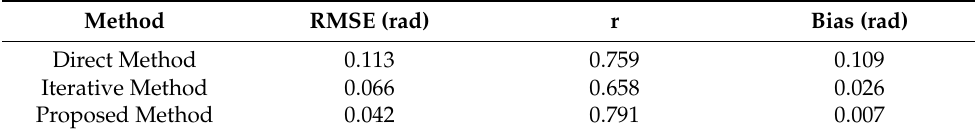
Figure 23. Results of the proposed method: ( a ) the calculated current filed, ( b ) the simulated interferometric phase, and ( c ) the scatter density map of simulated and extracted interferometric phases. Table 12. Statistics of the estimation results under different methods.